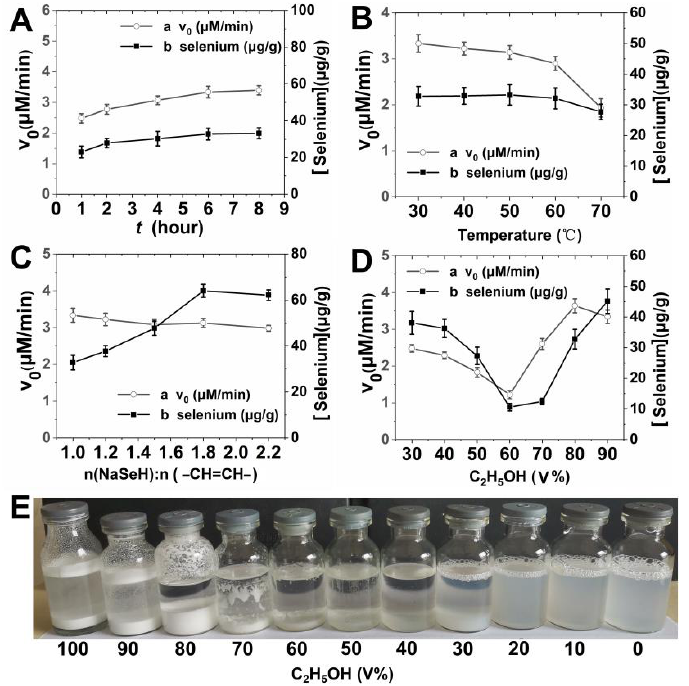
Figure 4. The υ 0 and the selenium content as the function of reaction time ( A ), reaction temperature ( B ), the mole ratio of NaSeH and − HC=CH − ( C ), and volume ratio of ethanol ( D ); the digital photographs of the reaction system with different volume ratio of ethanol ( E ).